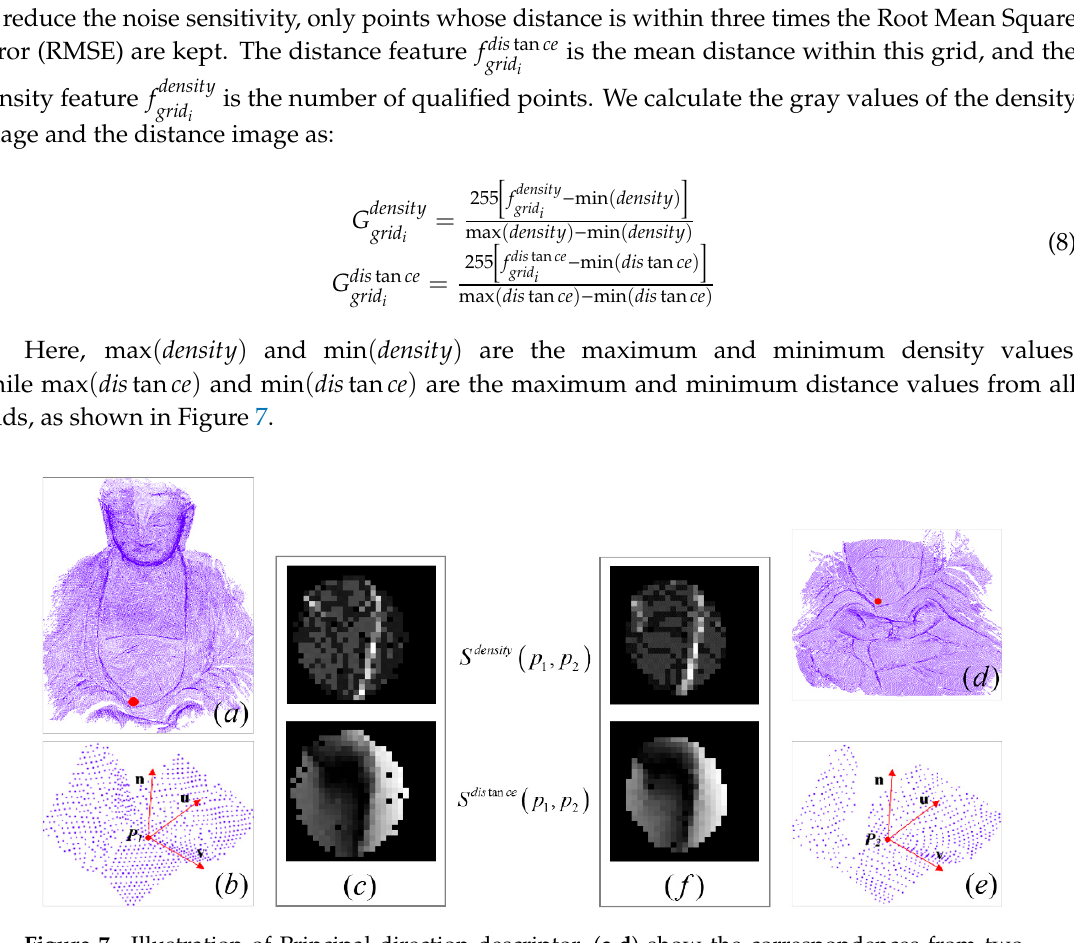
Figure 7. Illustration of Principal direction descriptor, ( a ) and ( d ) show the correspondences from two adjacent point clouds, ( b ) and ( e ) are the constructed local frames, ( c ) and ( f ) are the density image and distance feature image.